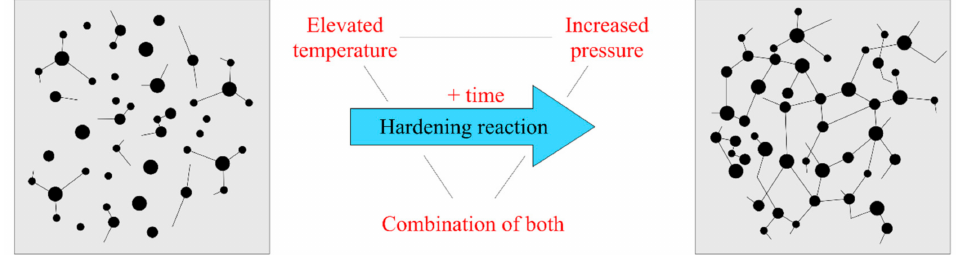
Figure 2. Diagram of a resin hardening